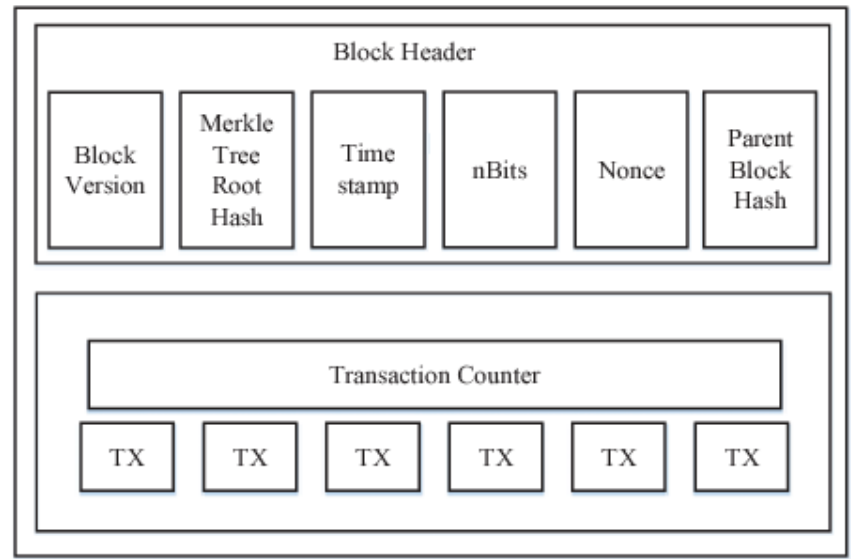
Figure 1. Architecture of Blockchain.